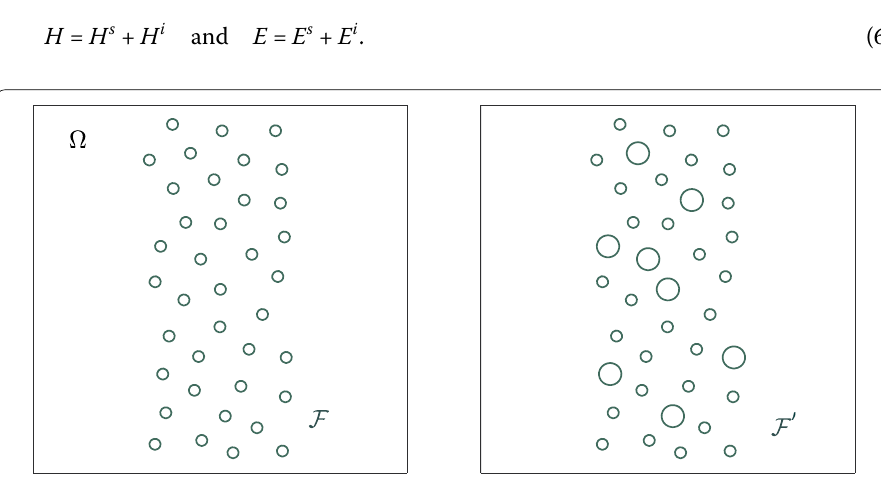
Figure 2 Stromal collagen fibres arrangement. Left: healthy cornea; Right: cornea with some fibres whose diameter is